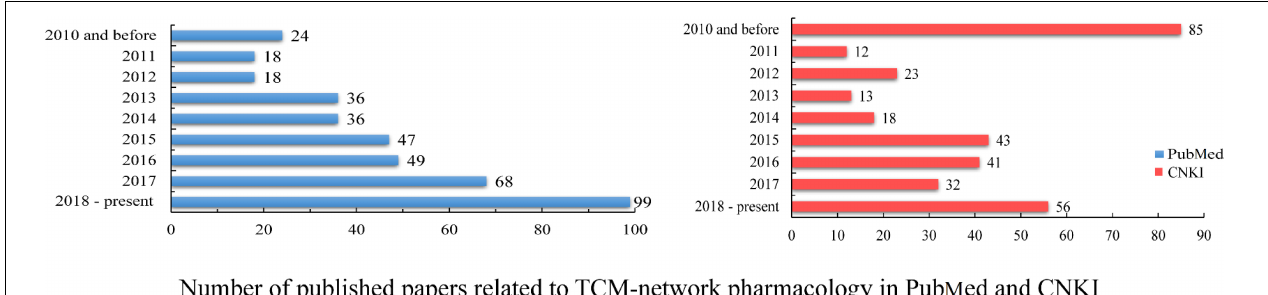
FIGURE 2 | Published papers identified from PubMed and CNKI databases. Papers in PubMed were searched by Title/Abstract containing the following keywords: “network pharmacology,” “Chinese,” and “medicine.” Papers in CNKI were searched with the following key words: “network pharmacology” and “Chinese herb,” excluding all conference papers. The analysis time was from 2010 and before, to the end of 2018. TABLE 2 | TCM network pharmacology studies in international journals from 2011 to 2017.